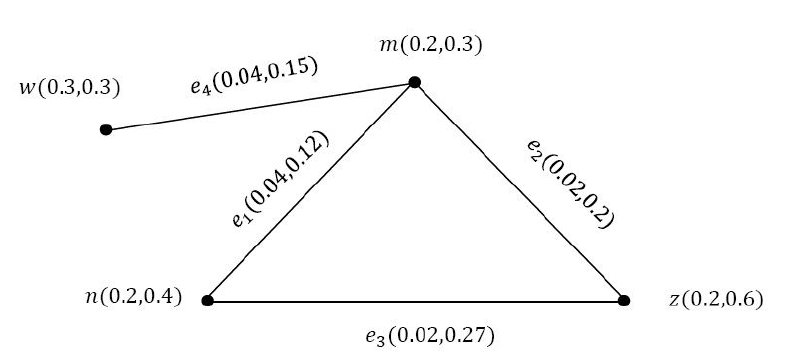
Figure 10. Minimal independent edge set in product vague graph ζ .